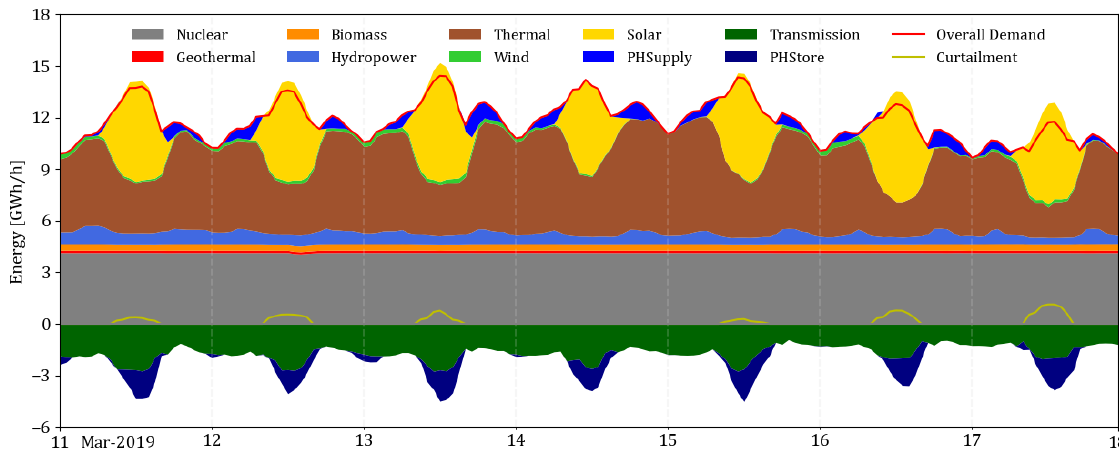
Figure 2. Curtailment Profile in Kyushu in March